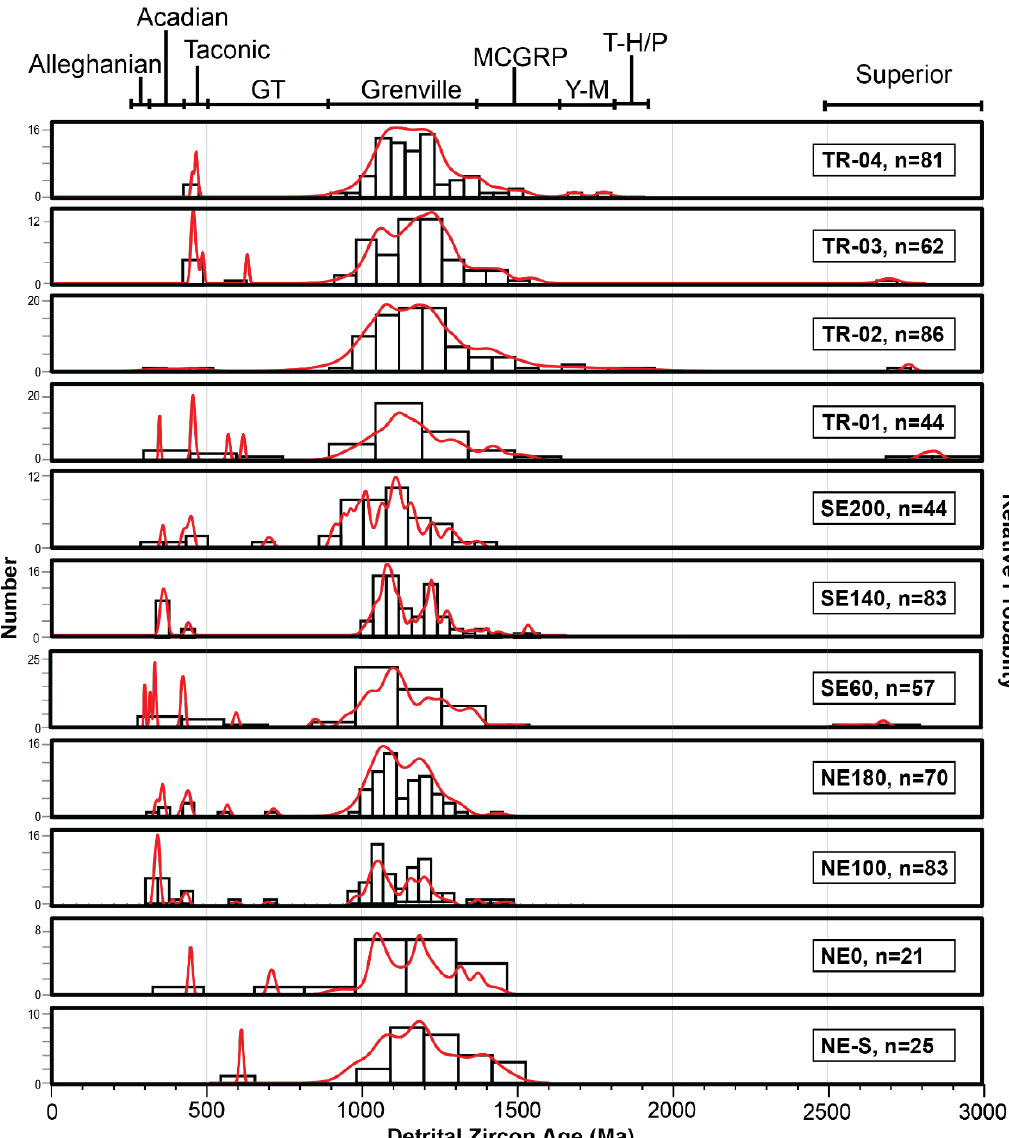
Figure 8. Stacked age-probability density plots of the 11 northern and southern samples.